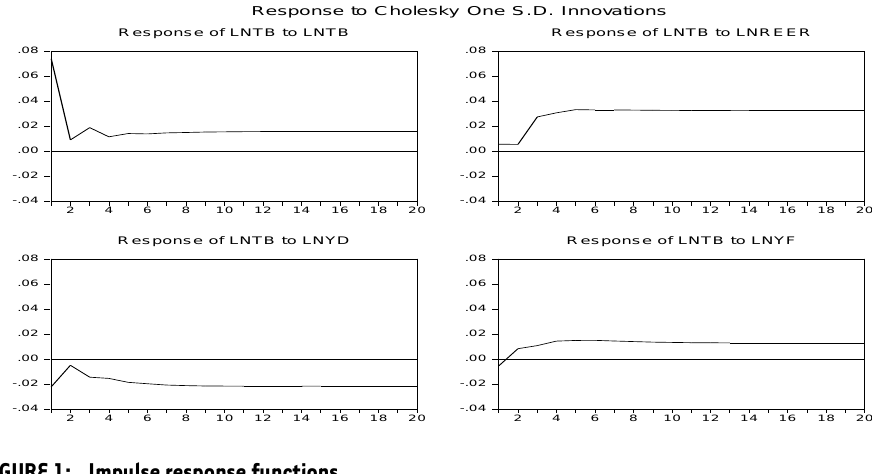
FIGURE 1: Impulse response functions Source: Eviews